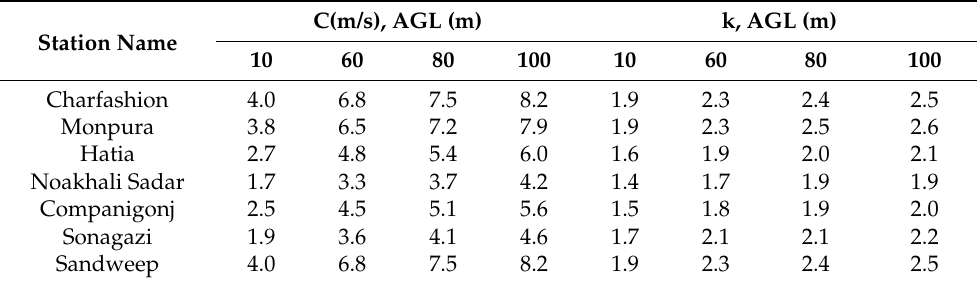
Table 4. Weibull probability distribution function.